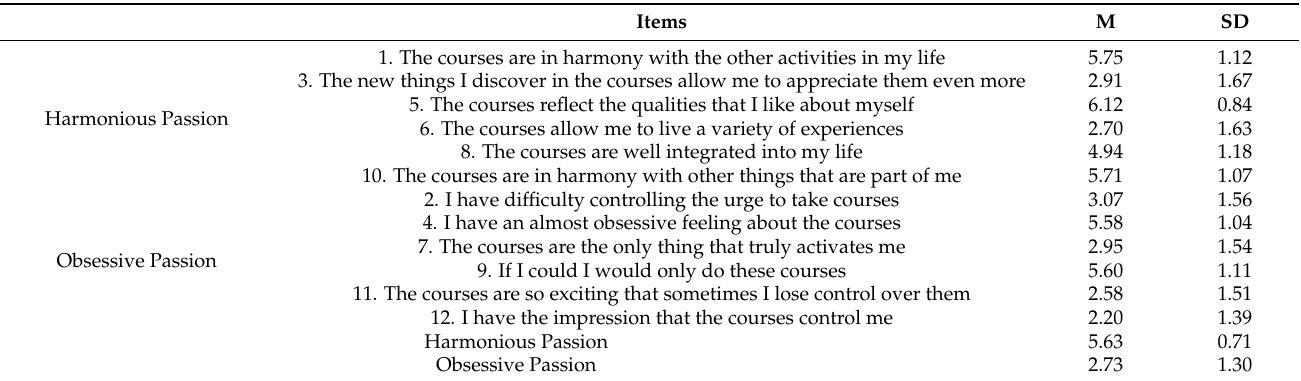
Table 8. Descriptive indicators of the DMP items and components.